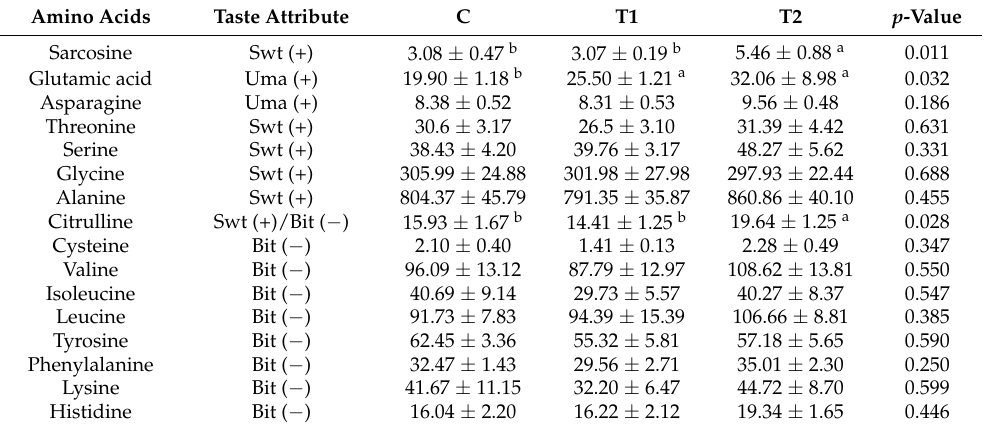
Figure 3. PLS-DA plot of the loin muscle metabolite in three groups ( a ). A total of 15 different metabolites were screened by metabonomics analysis ( b ). Carbohydrates and inorganic oxides were reduced in the screened differential metabolites when black soldier flies were given lipids and free amino acids, different colors represent different treatment groups: red represents group C, blue represents group T1, and green represents group T2. ( c ); n = 6. Table 5. Levels of major free amino acids in loin muscle of growing pigs in each group. Amino Acids Taste